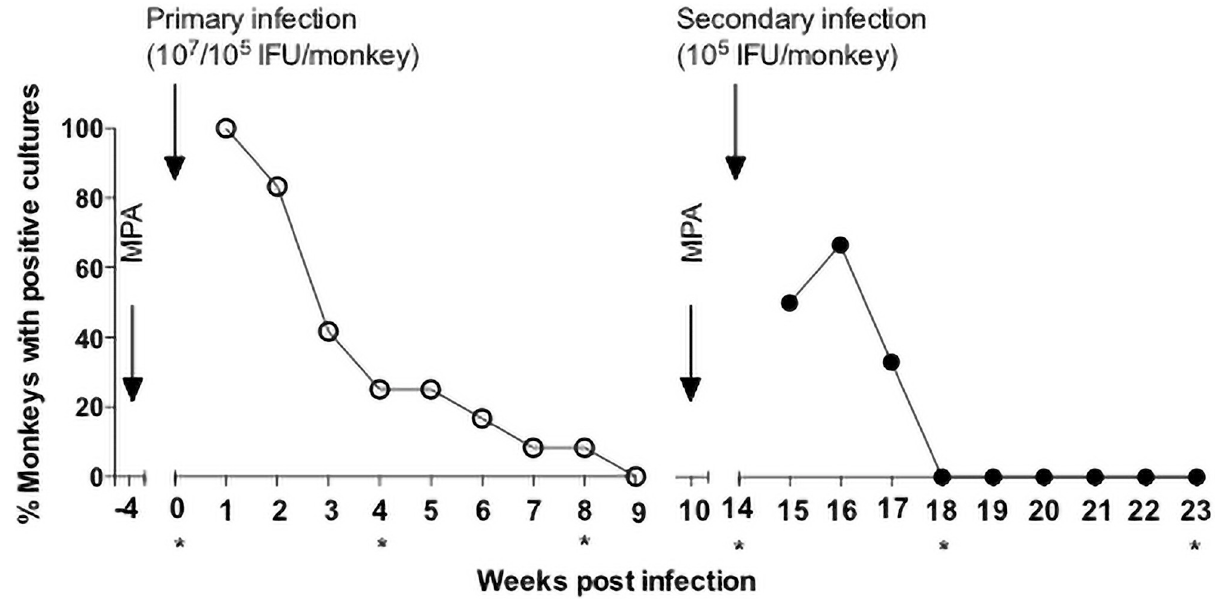
Fig 1. Vaginal cultures following primary and secondary C . trachomatis vaginal infections. Results of vaginal cultures collected from Rhesus monkeys following a primary and a secondary vaginal infection with C . trachomatis serovar D. � Times when sera was collected for testing with the